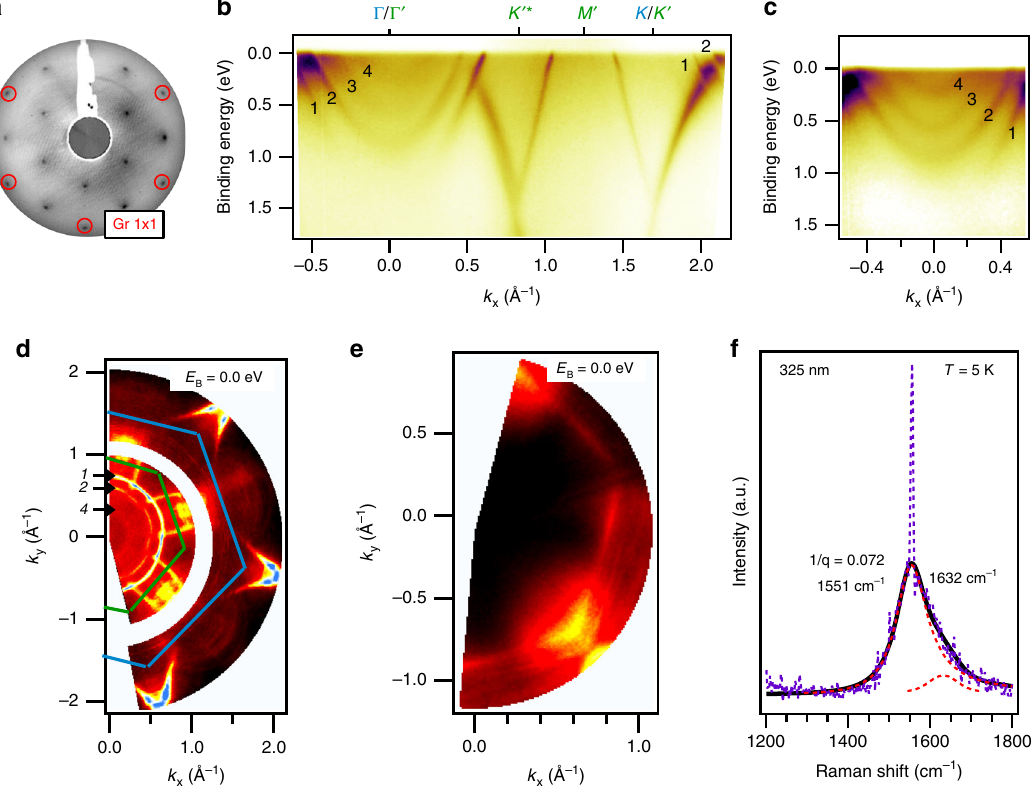
Fig. 2 Characterization of bilayer graphene/Ir(111) after evaporation of Cs. a LEED pattern ( E = 98 eV and T = 20 K) and b ARPES scan ( h ν = 31 eV and T = 17 K) of bilayer graphene/Ir(111) with Cs evaporated onto it. The quantum well states are labeled by 1 – 4. c Zoom-in into the region around Γ that shows four parabolic Cs quantum well states (1 – 4). d ARPES map at the Fermi energy ( E B = 0) of Cs-functionalized bilayer graphene. The quantum well states 1, 2, and 4 are indicated. The blue and the green partial hexagons denote the original and the zone-folded BZ, respectively. e Map as in d but before Cs deposition. f UHV Raman spectrum in the region of the G peak with a fi t of the lineshape and the Fano parameter 1 ∕ q . The black line is the fi t to the experimental data which are in violet color and dashed. The two red dashed line pro fi les centered at 1551 cm − 1 and 1632 cm − 1 are used for the fi tting. These two peaks are assigned to the graphene peak and to the feature that we observed before bilayer growth (cf. Fig. 1i and the discussion in the text),